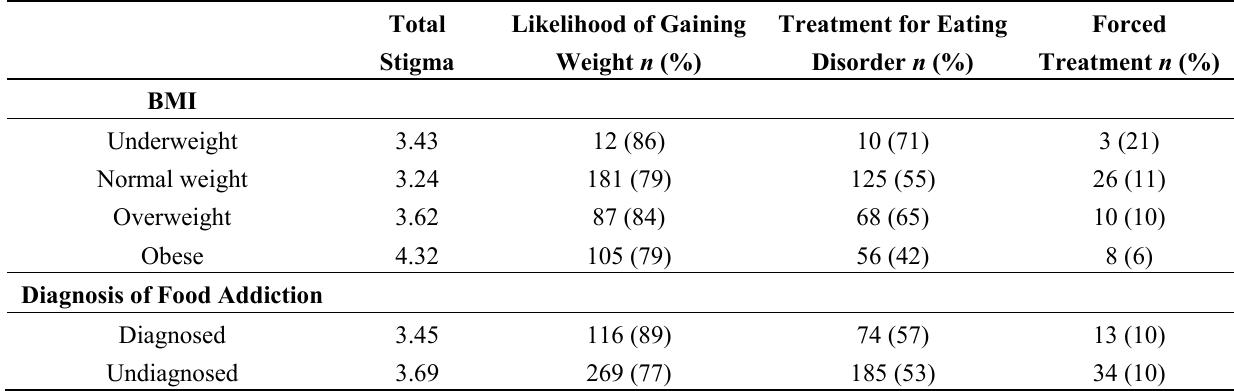
Table 4. Level of stigma and perceived treatment outcomes based on body mass index (BMI) and food addiction diagnosis.